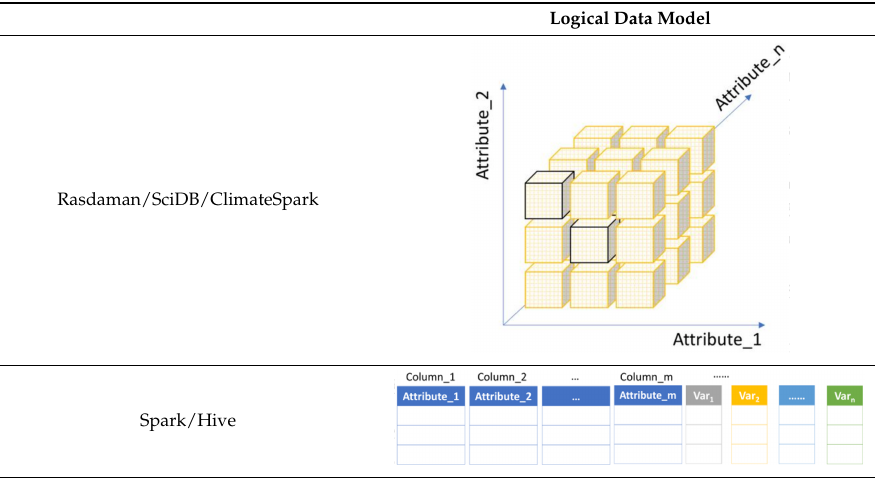
Table 3. The graphic illustration of the logical data